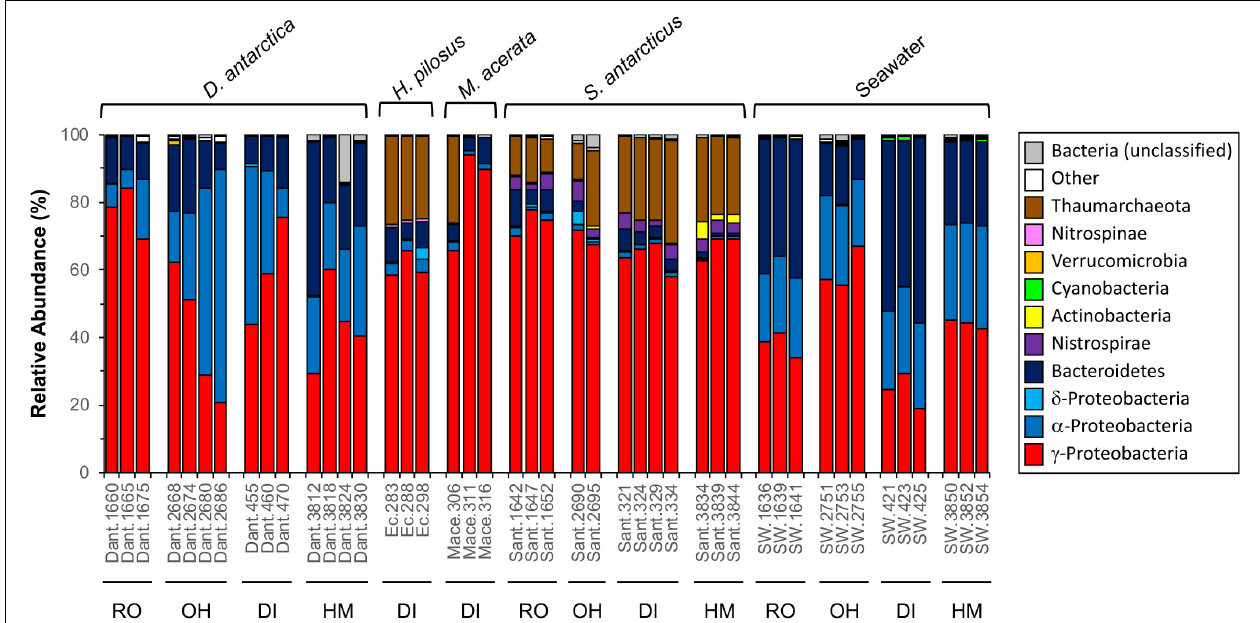
FIGURE 1 | Taxonomic composition of prokaryotic communities in Dendrilla antarctica , Sphaerotylus antarcticus, Mycale acerata , Hemigellius pilosus and surrounding seawater from O’Higgins (OH), Half Moon Island (HM), Deception Island (DI), and Rothera (RO).